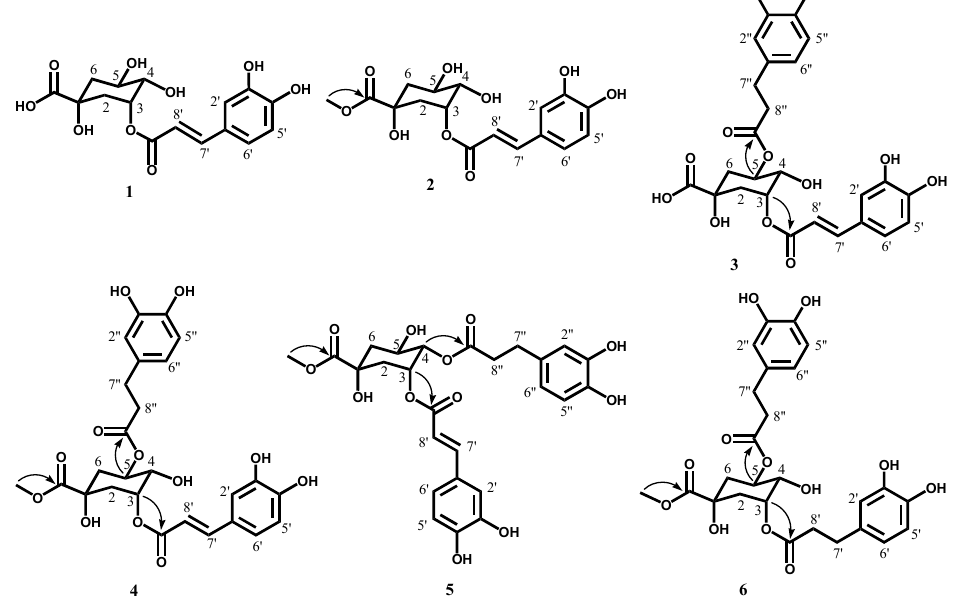
Figure 1. Structure of the isolated compounds and important HMBC correlations (arrows).